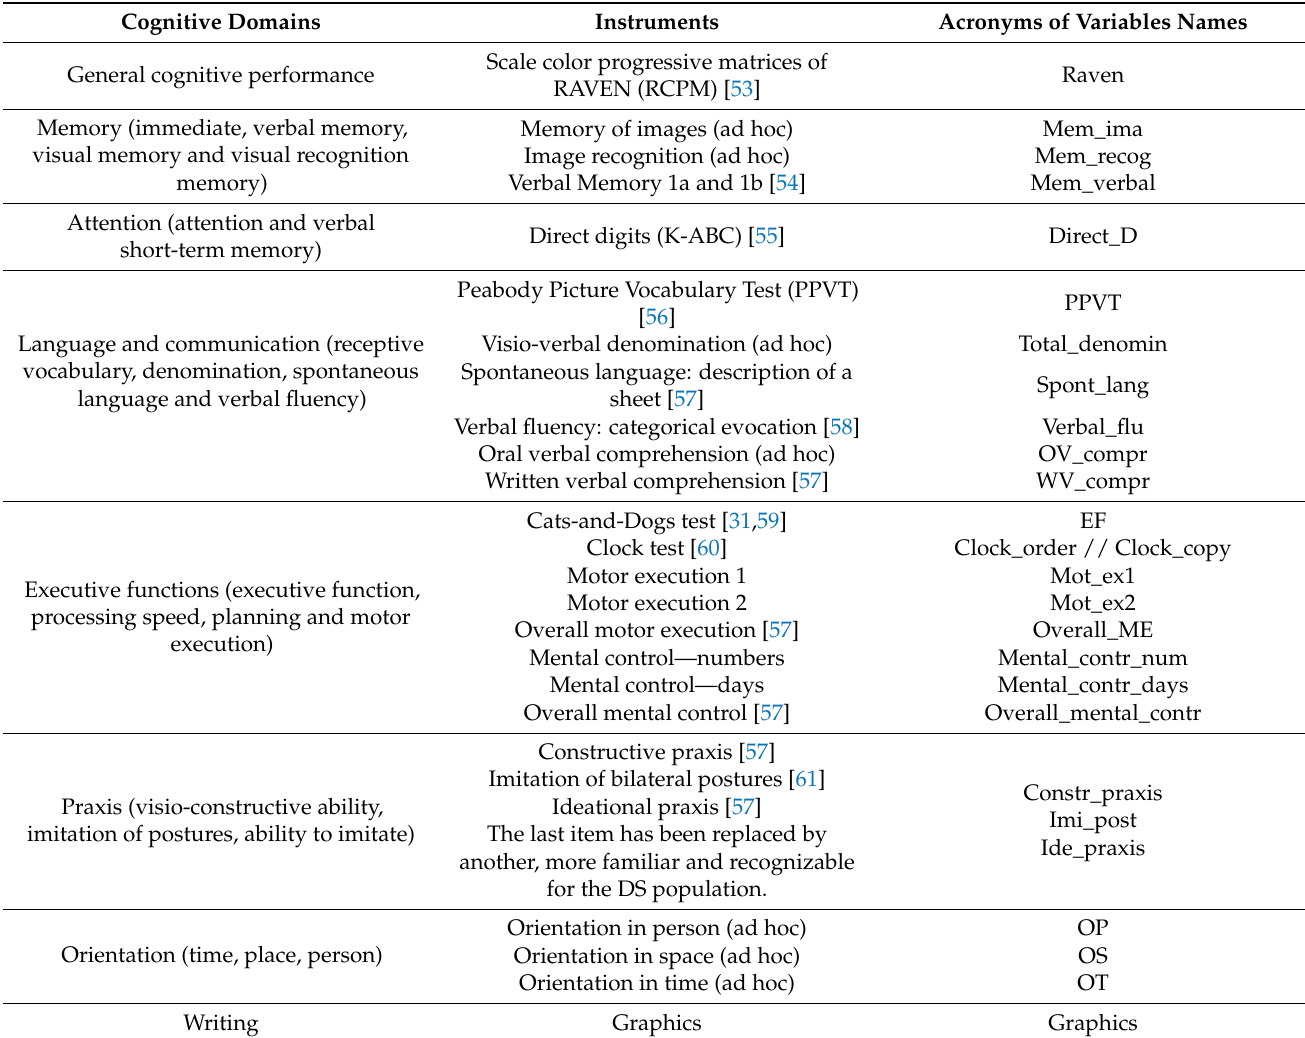
Table 1. Neuropsychological tests to perform the cognitive assessment of adults with DS